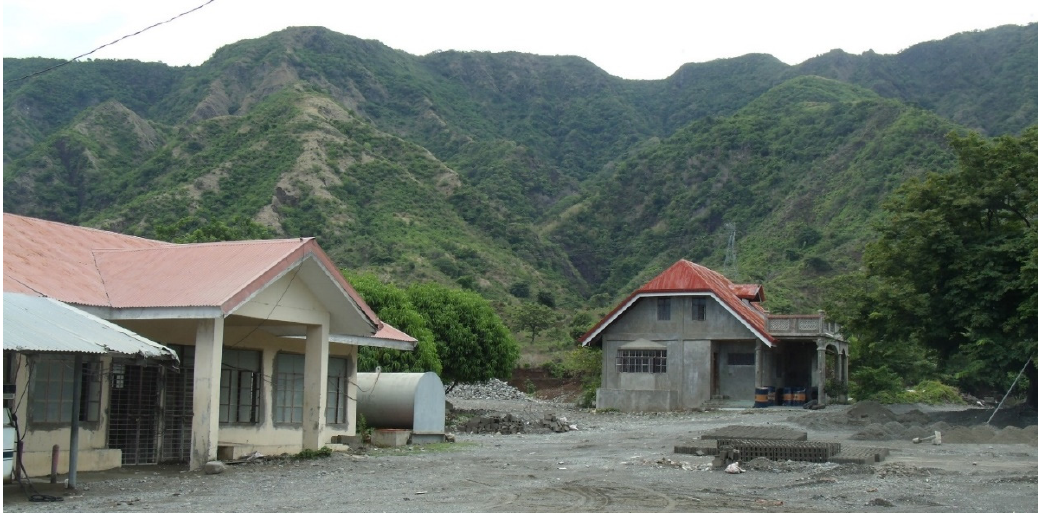
Figure 4. Left-laterally offset spurs and stream in Santa, Ilocos, Sur. Sinistral strike-slip faulting is indicated by the dominant lateral component of slip relative to the vertical component. Location of the photo is indicated by a black square in Figure 3.